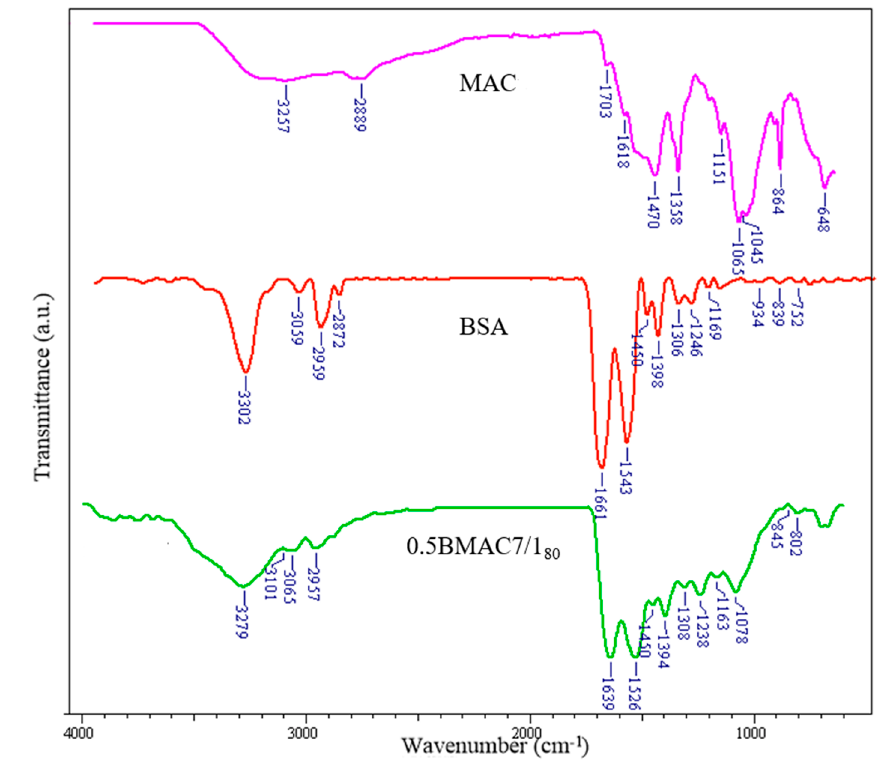
Figure 7. Fourier transform infrared (FT-IR) spectra of MAC, BSA, and 0.5BMAC7/180.